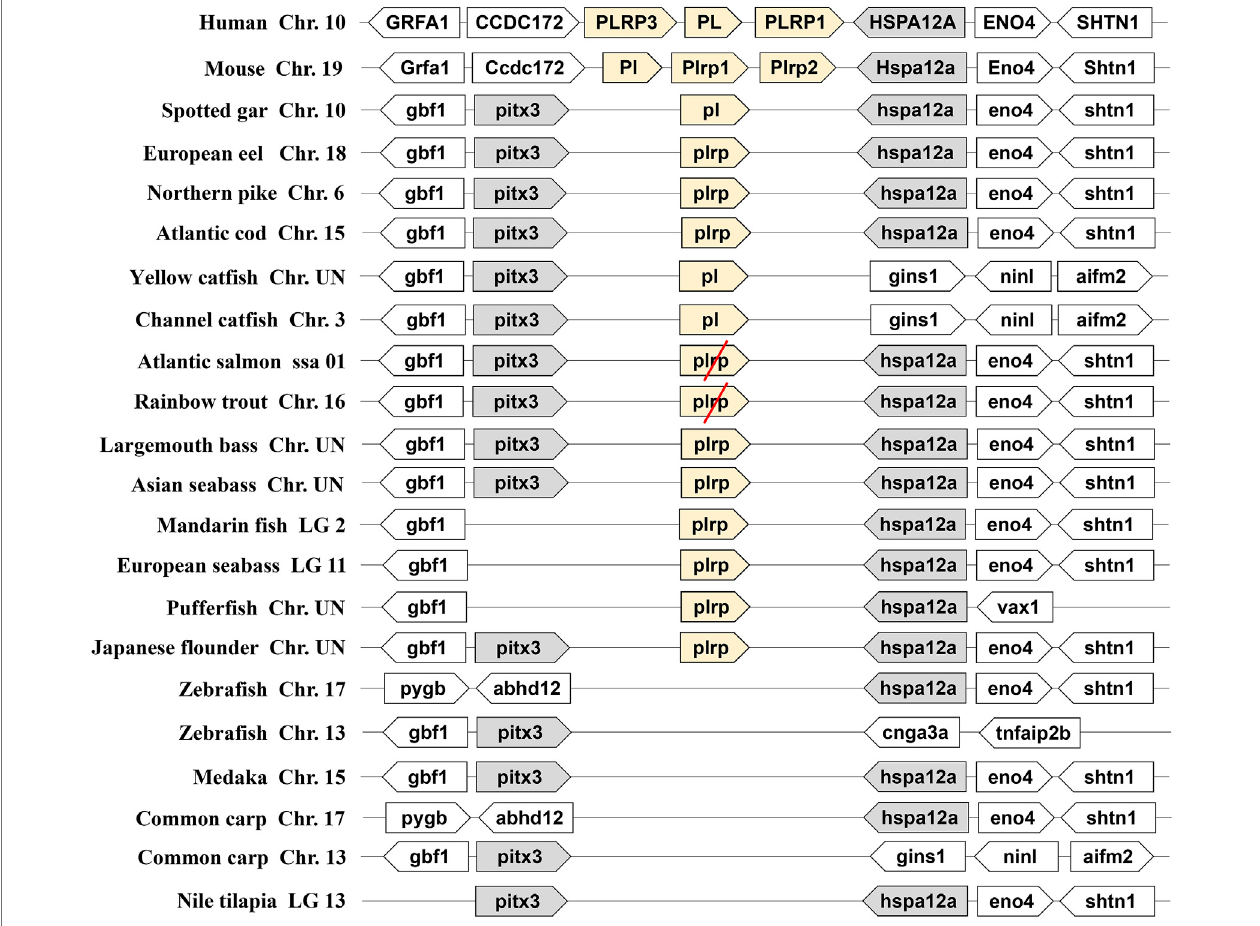
Frontiers in Genetics |